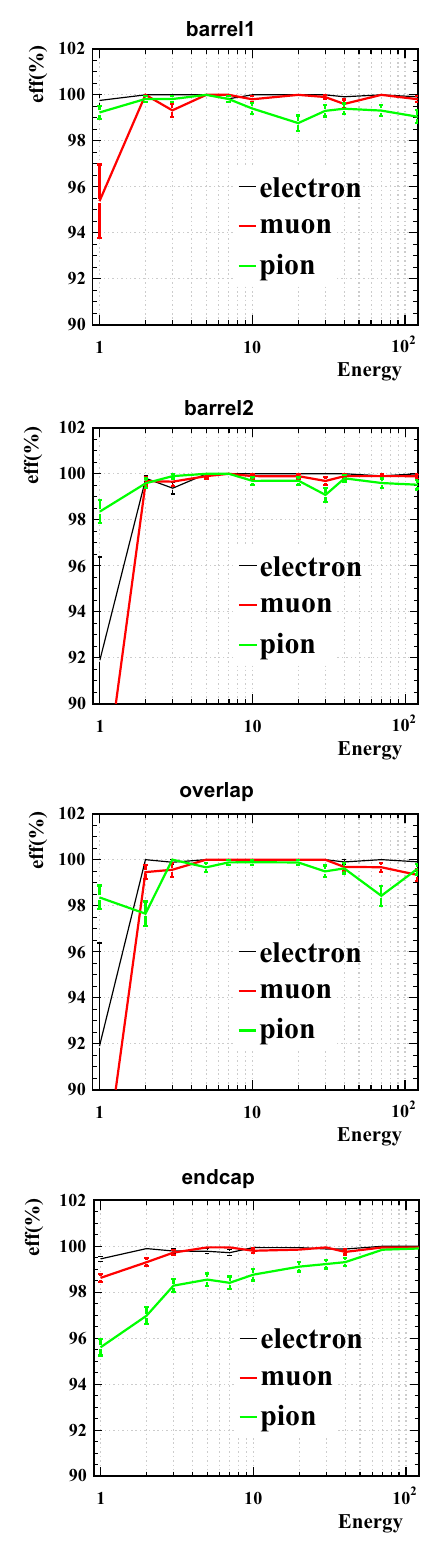
Fig. 5 The efficiency of lepton identification for e − , μ − and π + as function of particle energy in the four